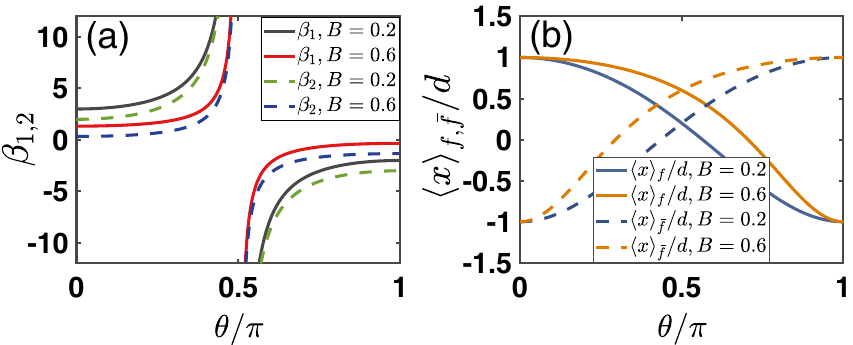
x in ( b ). Here � � f , ¯ f